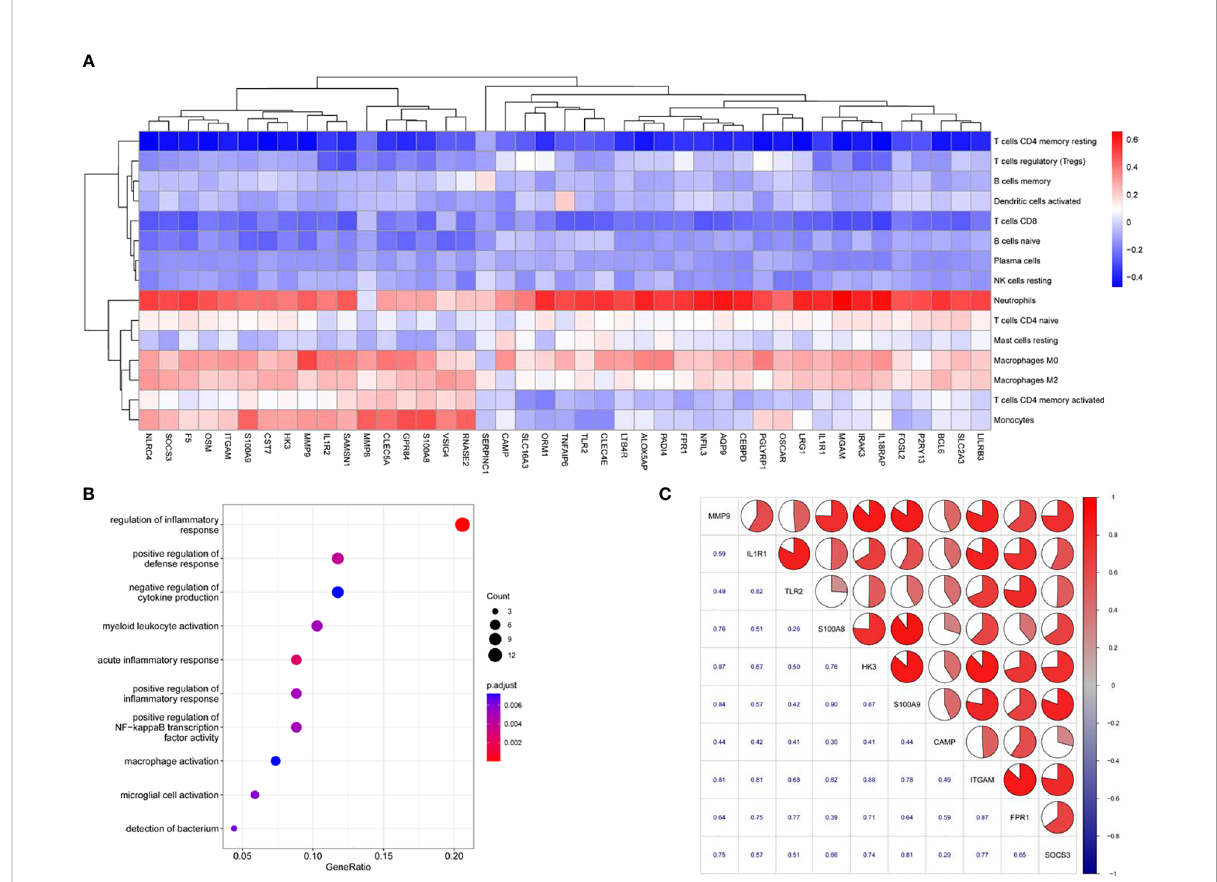
FIGURE 4 The potential functions of AP-related genes. (A) Heatmap denoting the relationships among the identi fi ed 43 highly connected candidate genes and immune cell proportions. Colored rectangles represent the Spearman correlation coef fi cient of transcript abundance for the highly connected candidate genes and fl uctuating immune cell proportions. (B) GO term enrichment analysis of 43 highly connected candidate genes for AP. (C) Correlation matrix of the expression pro fi les of hub genes of AP in human blood